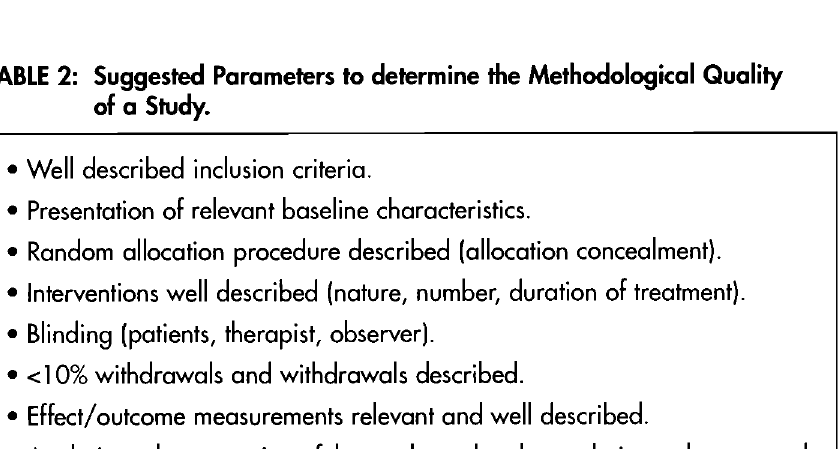
TABLE 2: Suggested Parameters to determine the Methodological Quality of a